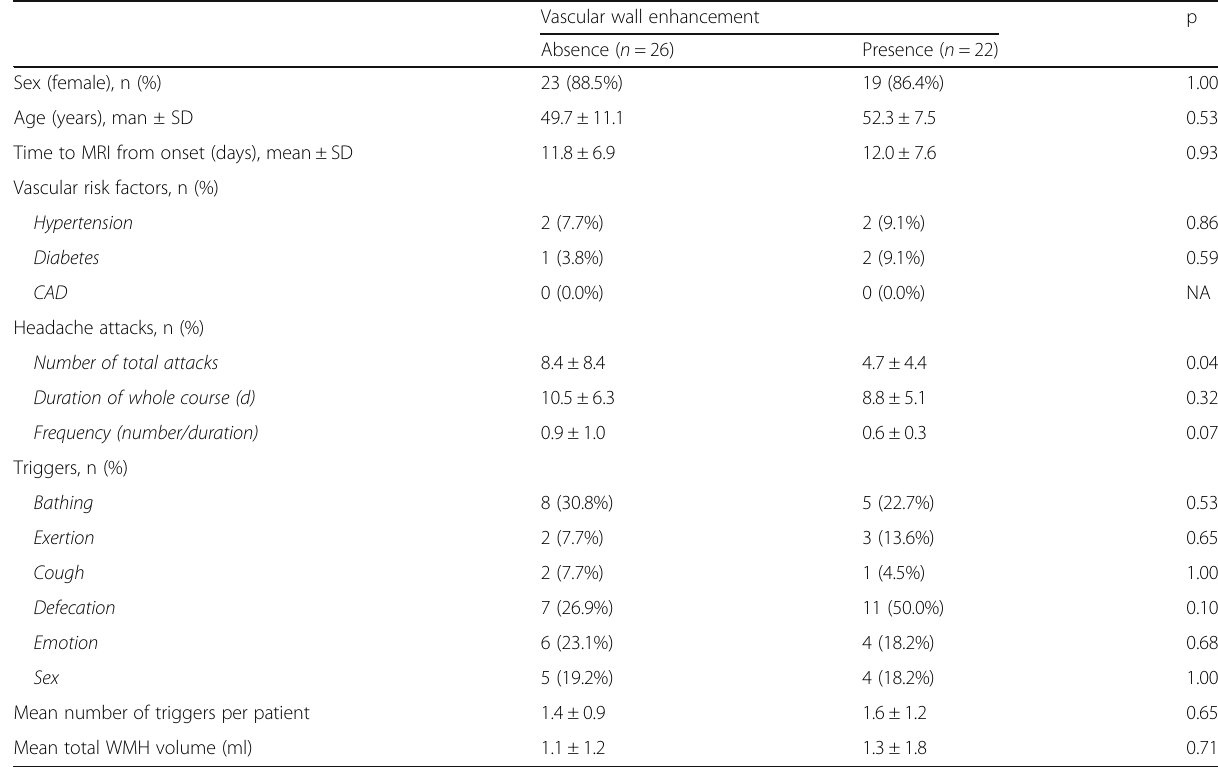
Table 3 Characteristics of the RCVS patients